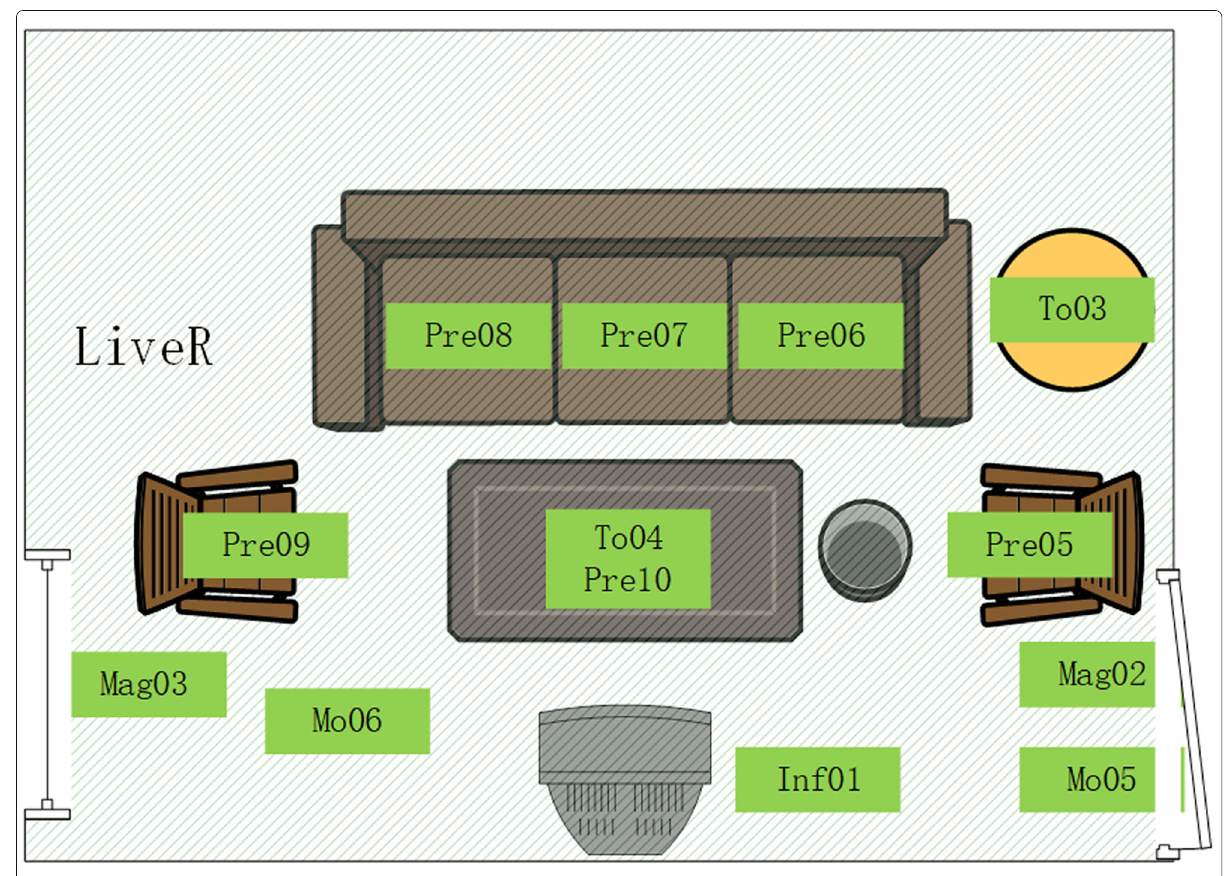
Fig. 2 A living room layout of multi-modeling sensors